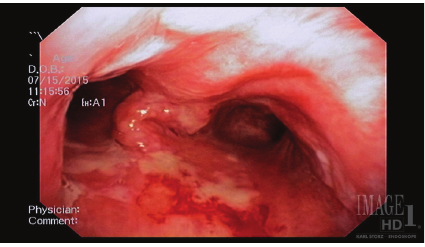
Figure 4: Postretrieval bronchoscopy